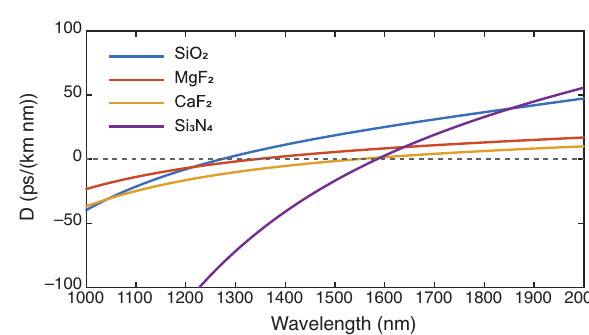
Figure 2: Resonance frequencies taking dispersion into account. The mismatch between the equidistant comb grid (black dashed line) and the resonance mode (blue) corresponds to the microresonator dispersion.